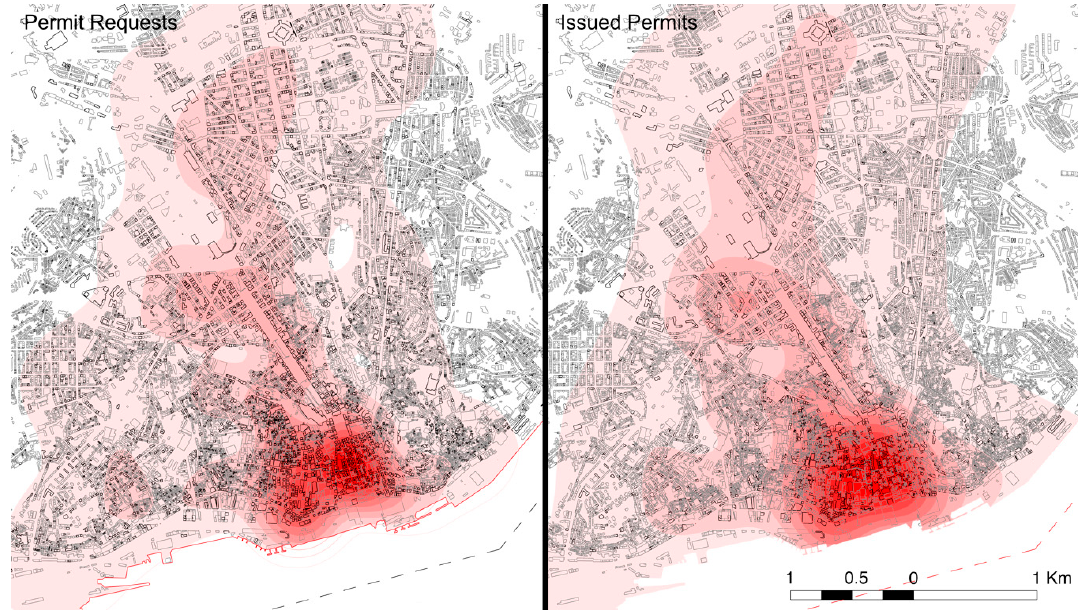
Figure 7. Left : Dual KDE of permit requests over the central area of Lisbon in the 2010–2016 period. Right : Dual KDE of issued permits over the central area of Lisbon in the 2010–2016 period. Source: Authors.